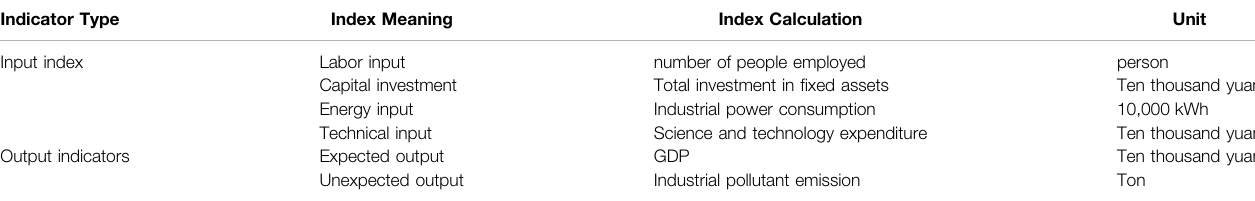
TABLE 2 | Evaluation index system of green growth ef fi ciency of oil and gas resource-based cities. Indicator Type